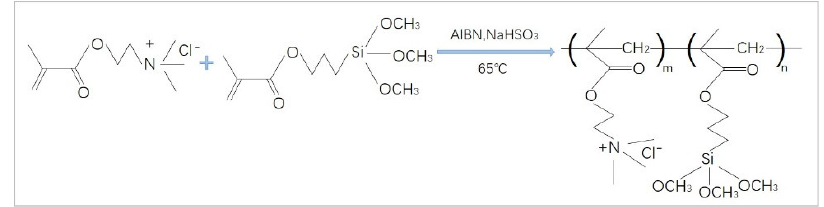
Figure 2. Synthetic route of polymer PMETAC-PTSPM